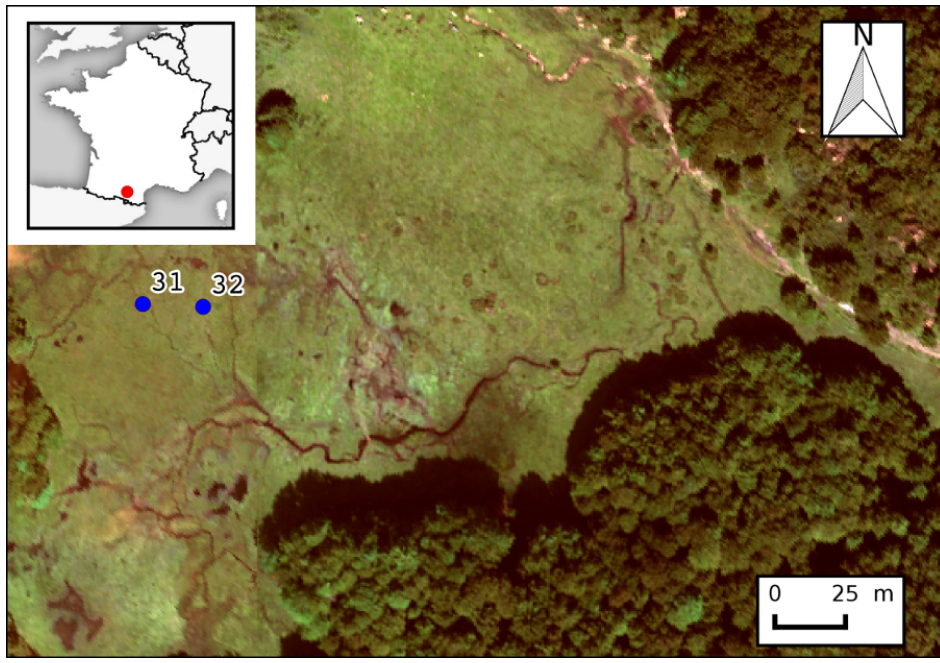
Figure A25. Location of the in situ spectroradiometer measurements for the plots of Pinguicula sp. combined vegetation (PI_CV).